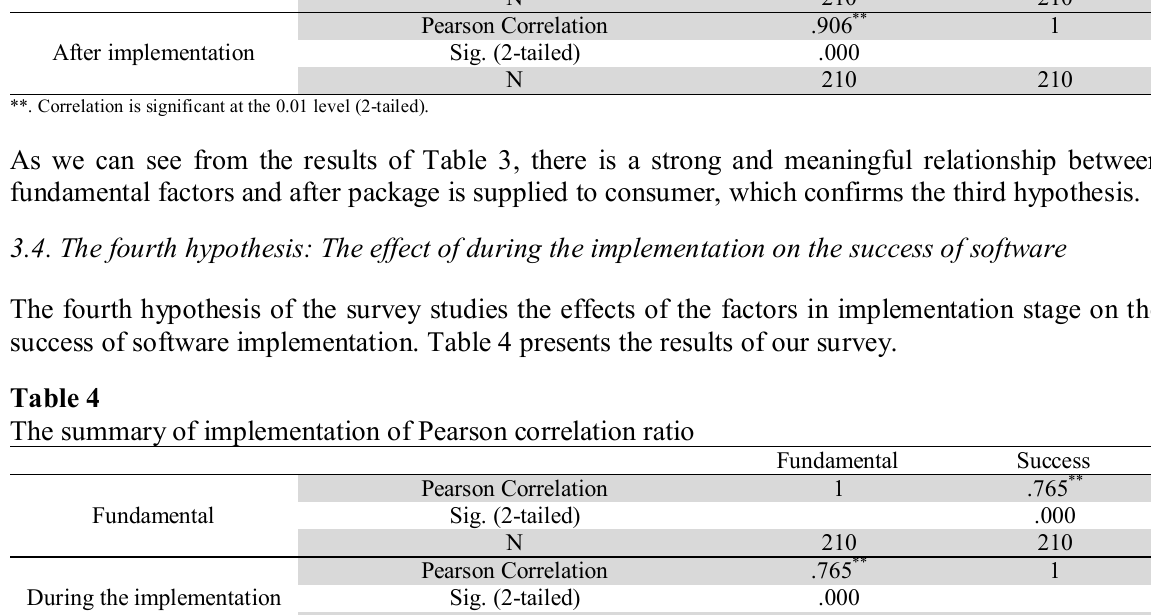
The summary of implementation of Pearson correlation ratio for testing the last hypothesis Pearson Correlation Fundamental Pearson After implementation